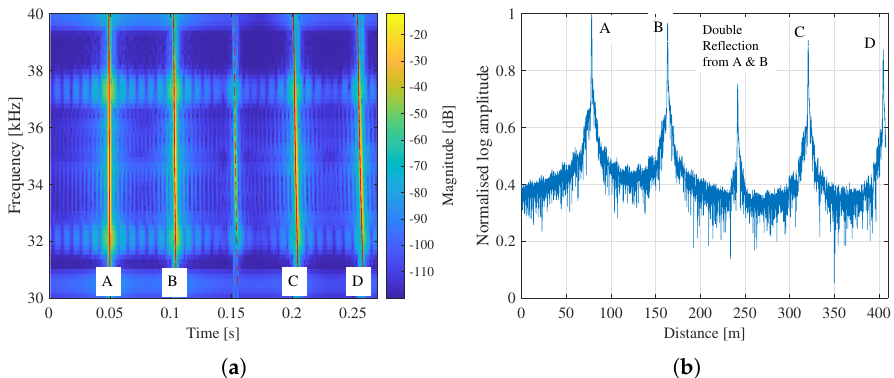
Figure 4. ( a ) Spectrogram of the simulated baseline signal (mode 7 only) and ( b ) the equivalent distance domain signal.